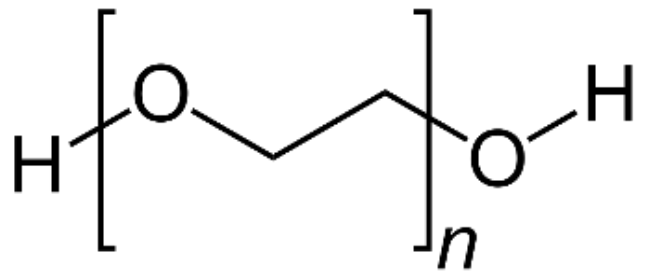
Figure 1. Chemical Structure of PEG.